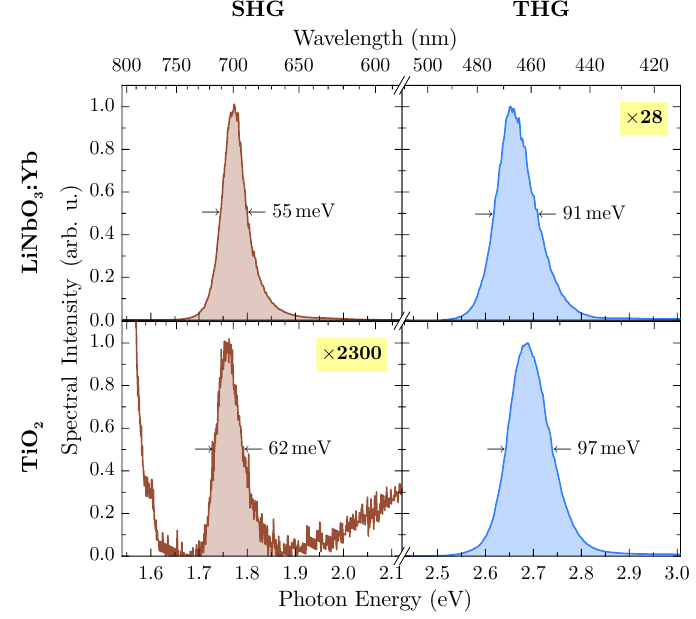
Figure 6. Baseline-corrected and normalized emission spectra of LiNbO 3 :Yb- ( top ) and TiO 2 -nanopowder ( bottom ) at a fundamental wavelength λ ω = 1400nm. The less intense peak has been scaled up to unity with displayed factors for clarity. Fundamental intensities for both samples are on the order of ( 9 ± 2 ) × 10 15 W/m 2 . Peak areas for calculation of the harmonic ratio are